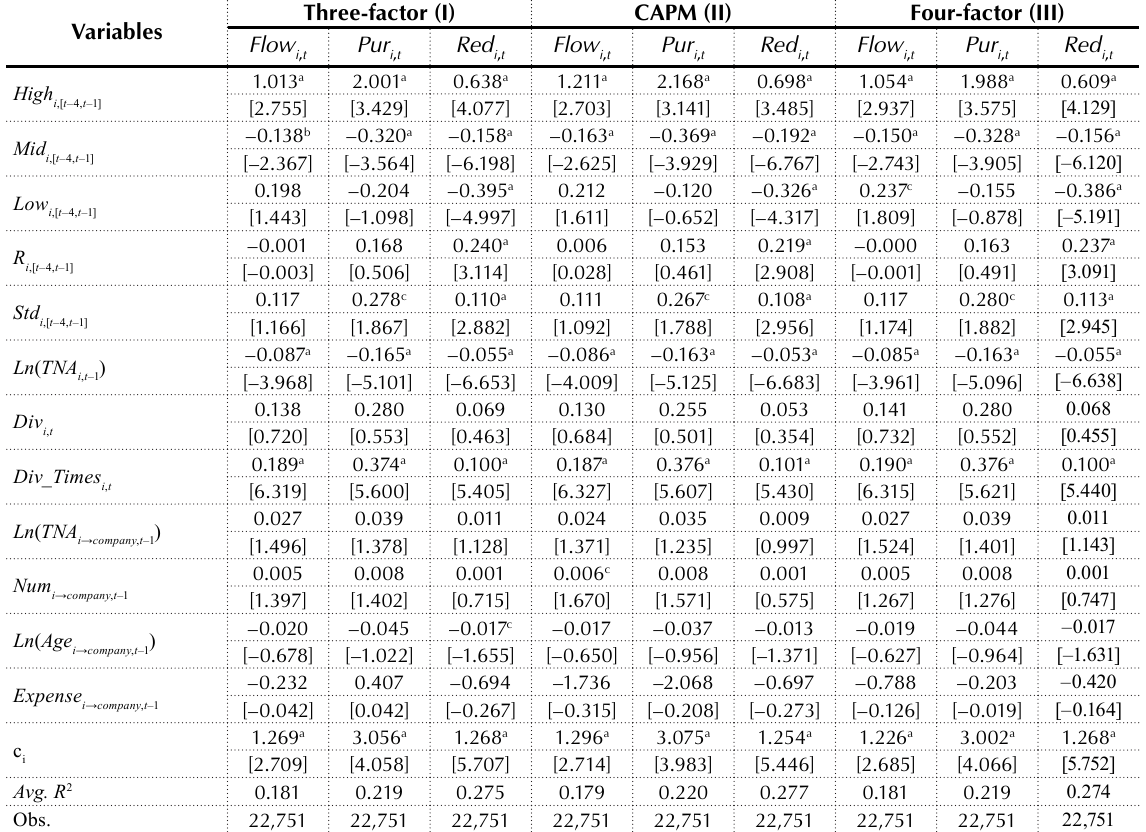
Table 7. Robustness test: the adoption of tradable shares in computing pricing